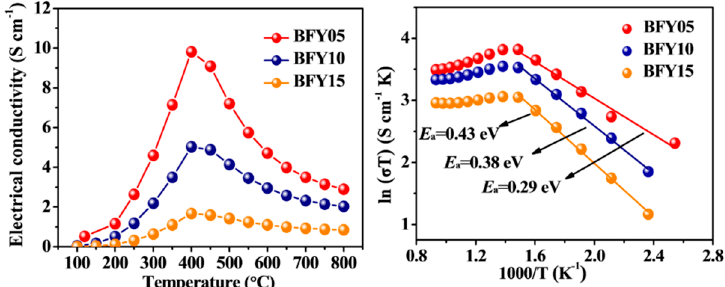
Figure 3. ( a ) The electrical conductivity of BFY x samples at 100–800 °C; ( b ) Arrhenius plots of BFY x with temperature.